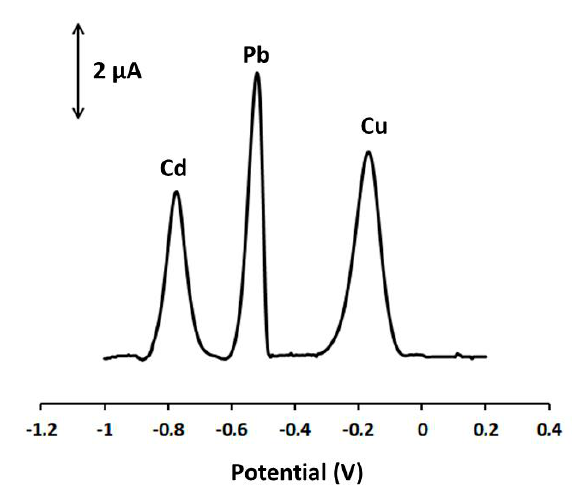
Figure 5. DP voltammograms at the Ca-MOF/GPE of 40 µg L − 1 Pb(II), 80 µg L − 1 Cd(II), and 80 µg L − 1 Cu(II) in 0.1 mol L − 1 acetate buffer (pH 4.5). Preconcentration potential: − 1.2 V; preconcentration time: 360 s; pulse 40 mV for 10 ms ; scan rate: 10 mV s − 1 .